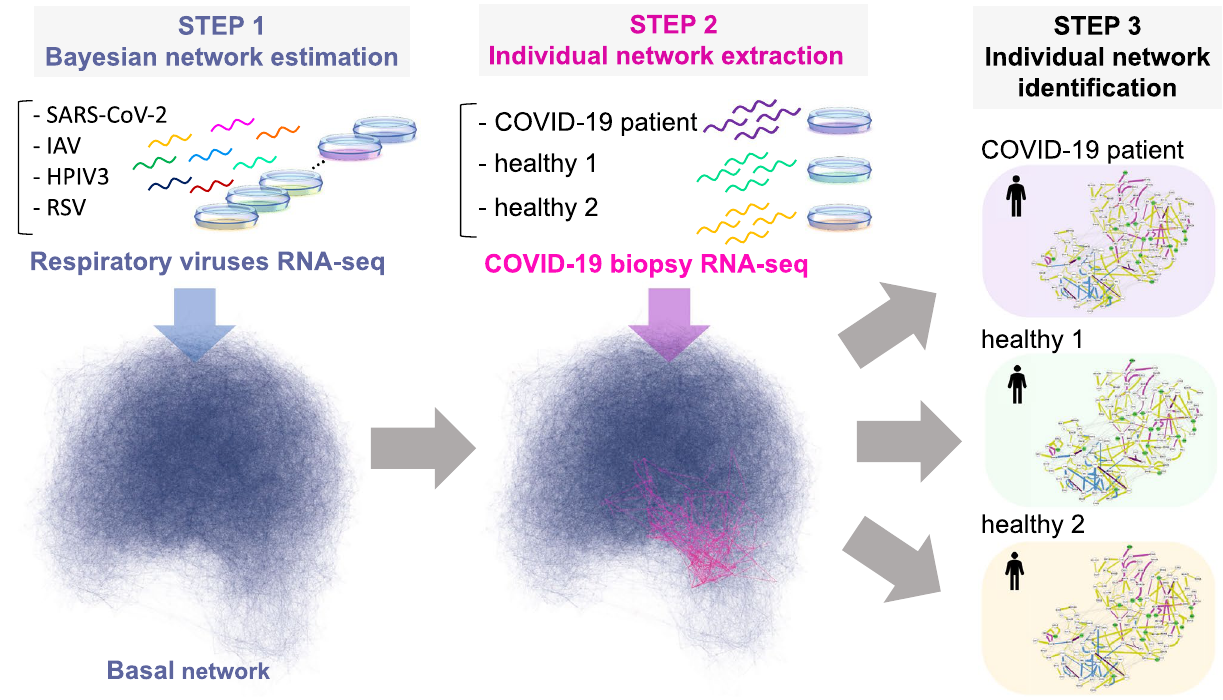
Figure 1. Illustration of overview. The hairball (blue) is the basal network consisting of 127,126 edges and 15,258 nodes established using the respiratory viruses RNA-seq including SARS-CoV-2. The highlighted- network (magenta) in the basal network represents the COVID-19-perturbed network extracted by using the biopsy